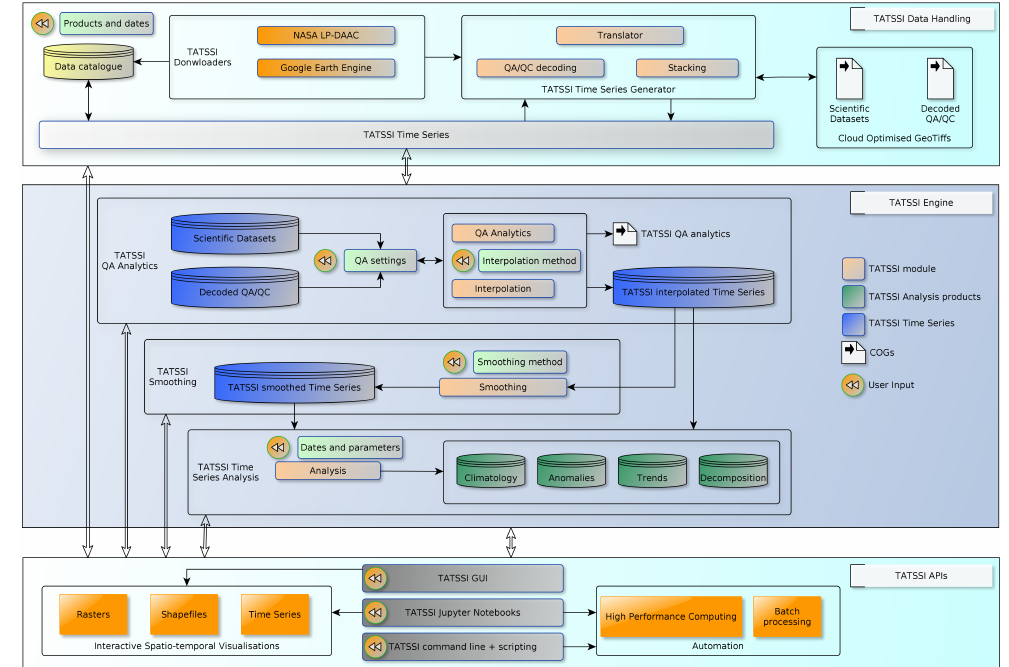
Figure 1. A graphical representation of the Tools for Analyzing Time Series of Satellite Imagery (TATSSI) architecture and